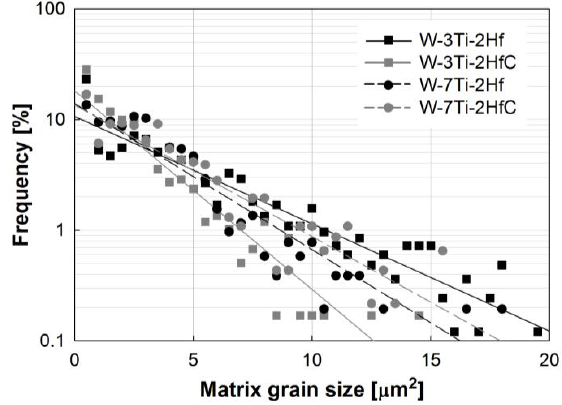
Figure 4. Frequency plot of matrix grain